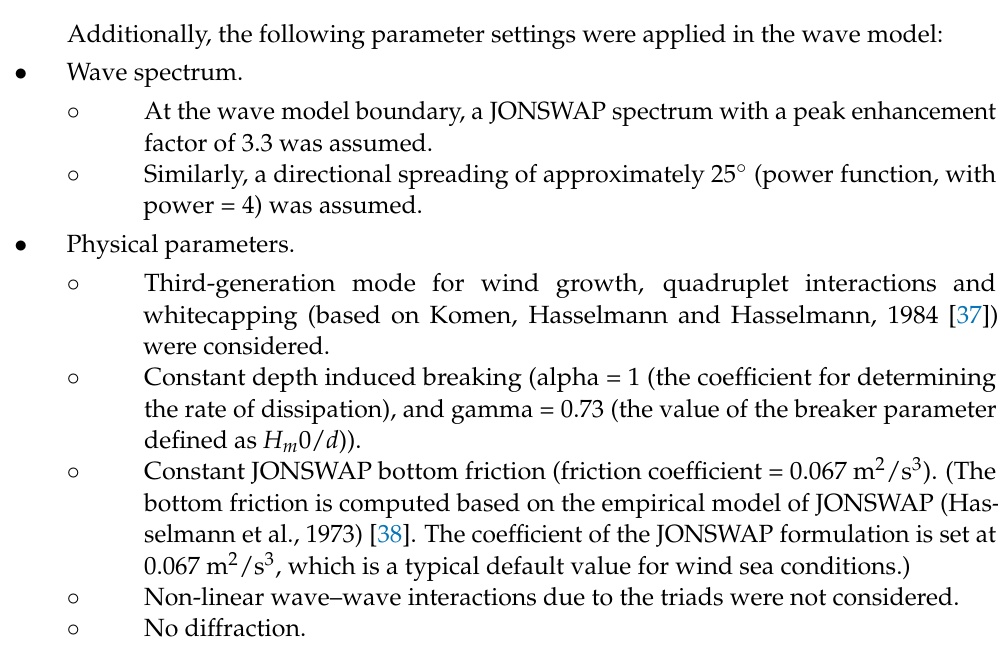
Figure 7. Map of MOV stations (red squares) where 3-hourly data on wind velocity, H s , T p and D p were extracted. On the other hand, the yellow circle is the PAGASA Cuyo station where daily wind data were recorded.